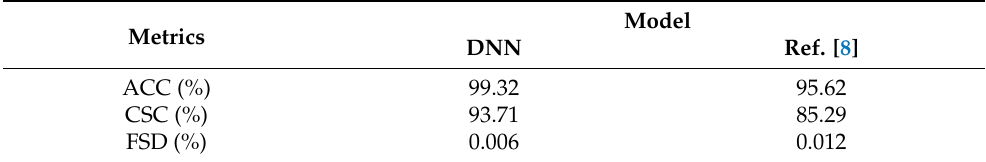
Table 5. Overall metrics measured from DNN for the JA CT model.